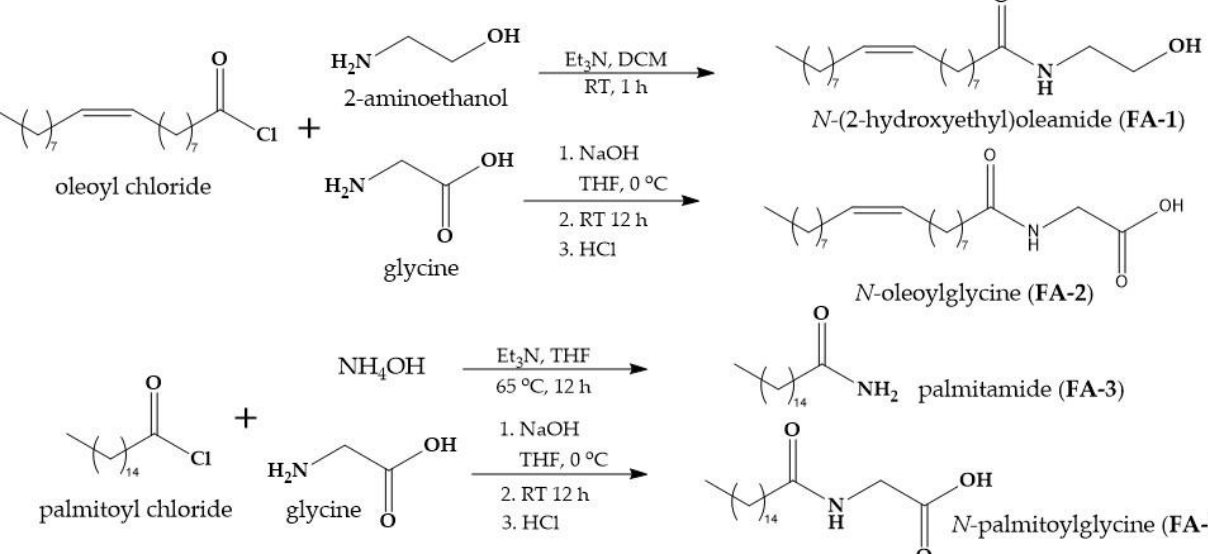
Figure 1. The synthetic strategy for the fatty acid amides.